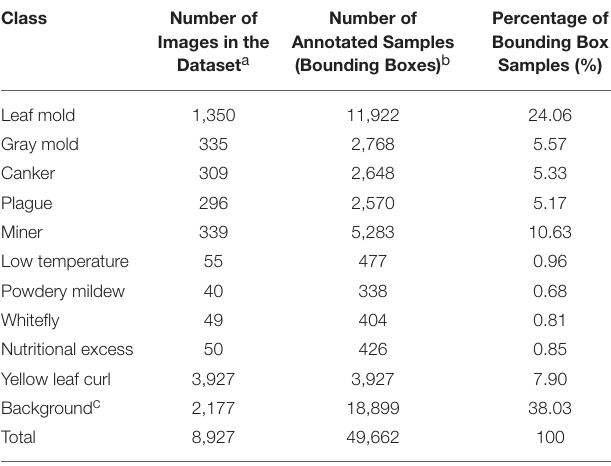
TABLE 2 | List of categories included in our tomato diseases and pests dataset and their annotated samples.